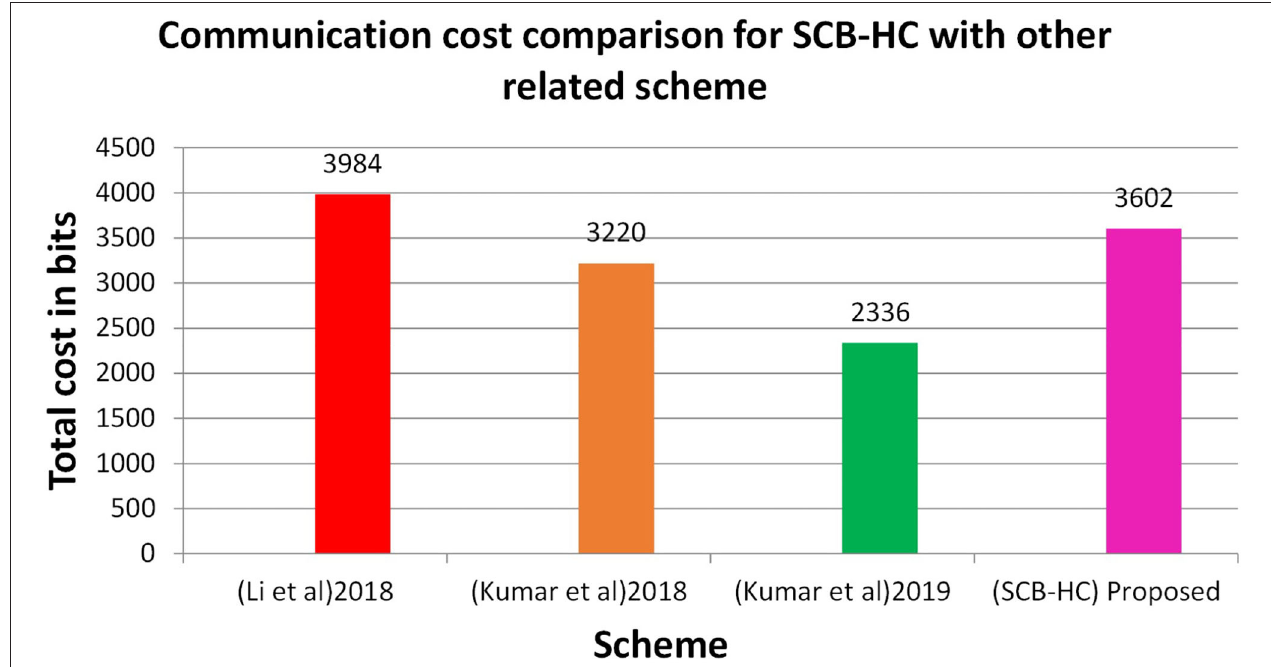
FIGURE 7 | Communication cost for various